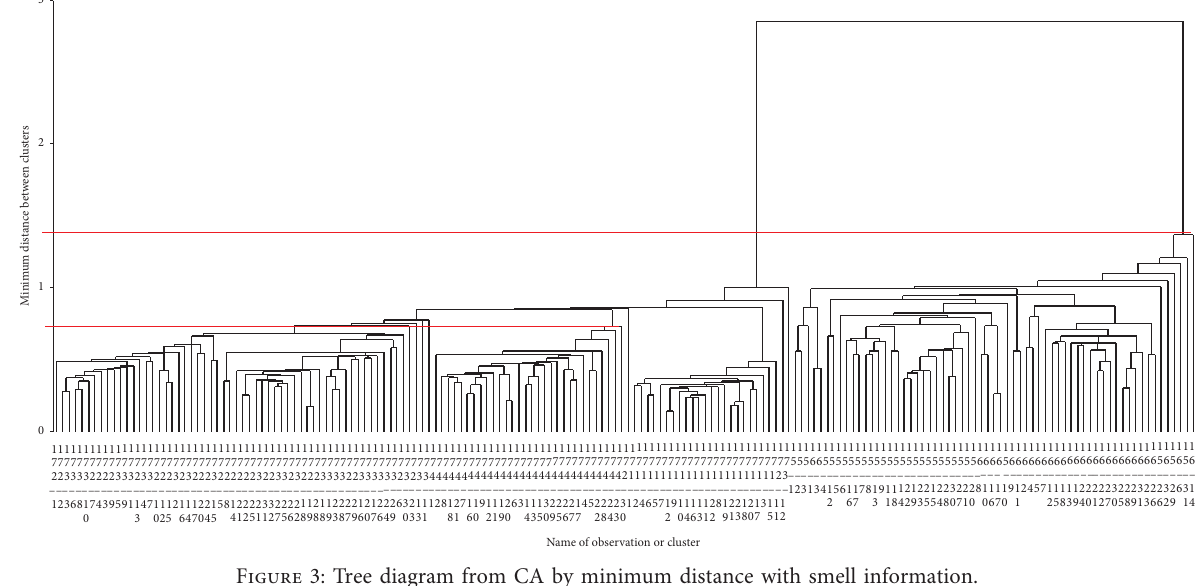
Figure 3: Tree diagram from CA by minimum distance with smell